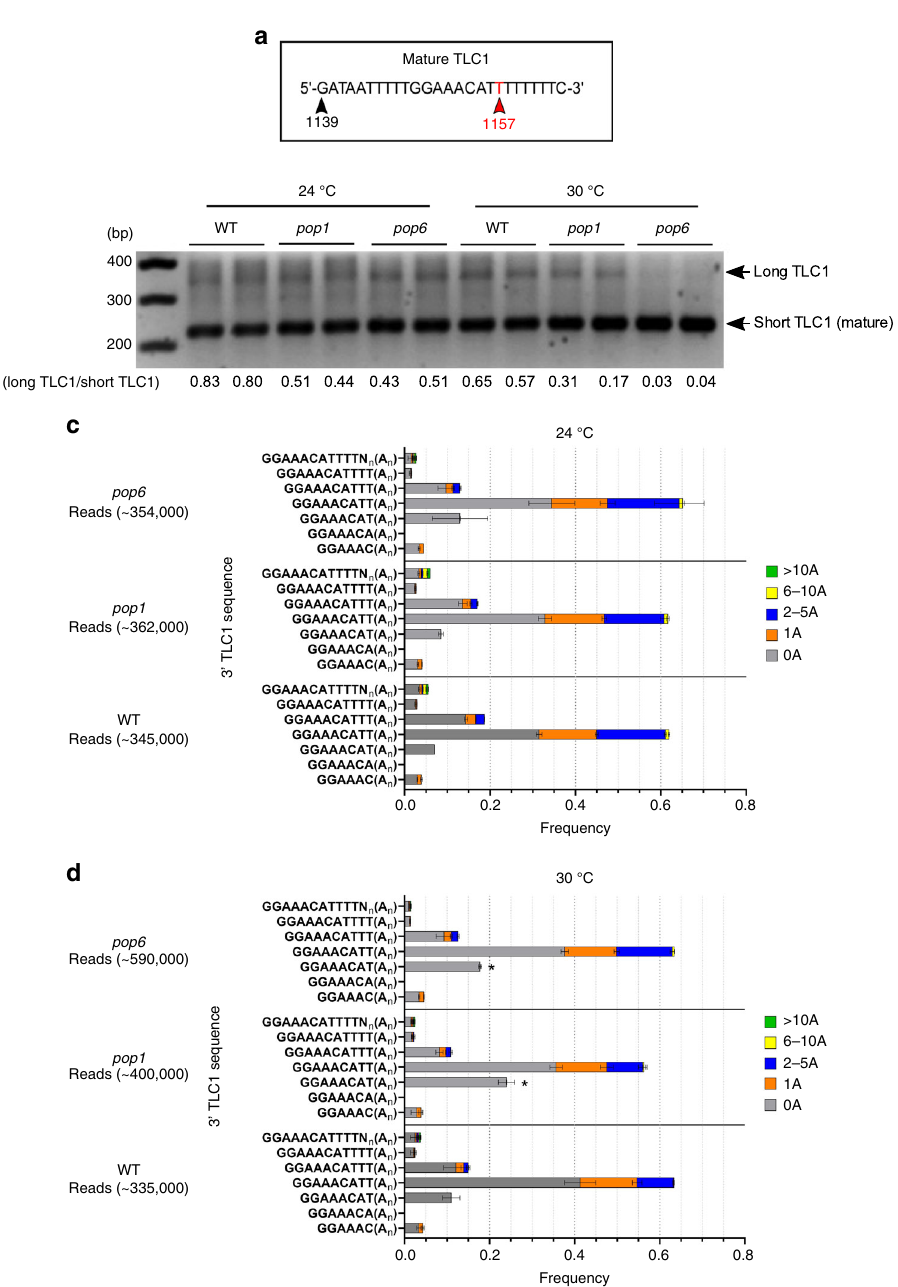
Fig. 6 Processing of TLC1 3 ′ ends is not altered in pop cells at 24 °C. The 3 ′ end sequences of TLC1 extracted from 24 or 30 °C grown cells were analyzed by 3 ′ RACE. a Diagram of the 3 ′ end of TLC1 from nucleotides 1139 to 1164. The last nucleotide in the 1157 nt mature TLC1 molecule is indicated with a red arrowhead. b PCR products ampli fi ed from TLC1 cDNA were analyzed on a 1% agarose gel. The expected sizes of mature and precursor forms of TLC1, are, respectively, ~220 and ~350 bp. Compared to WT, the relatively abundance of short to long forms were higher in pop1 and pop6 cells at 24 °C and, especially, 30 °C. Ratios of long to mature form are shown below lanes. All amplicons <500 nts shown in panel B were puri fi ed and deep sequenced. The relative abundance of each TLC1 species as determined by sequencing was quanti fi ed. Sequences that aligned to the 1154 to >1159 nt end of TLC1 with or without a poly(A) tail are shown for cells grown at c 24 °C or d 30 °C. The size of the poly(A) tails are: no adenosine (gray), 1 adenosine (orange), 2-5 adenosines (dark blue), 6 – 10 adenosines (yellow) and >10 adenosines (green). Total reads are indicated. Each bar shows the average from biological duplicates. At 30 °C, transcripts ending at nt 1156 [no poly(A)] were signi fi cantly more abundant by an unpaired two-tailed Student ’ s t -test in pop1 and pop6 versus WT (marked with asterisk). Source data are provided as a Source Data fi